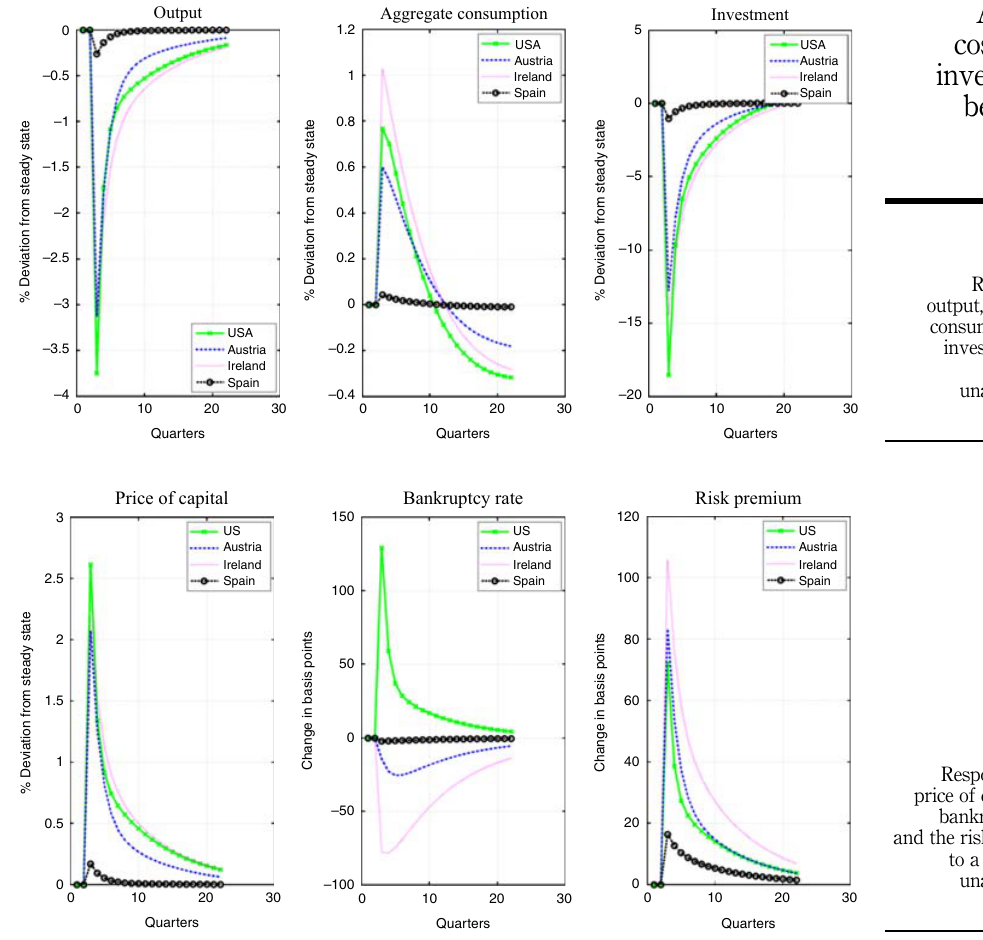
Figure 6. Response of the